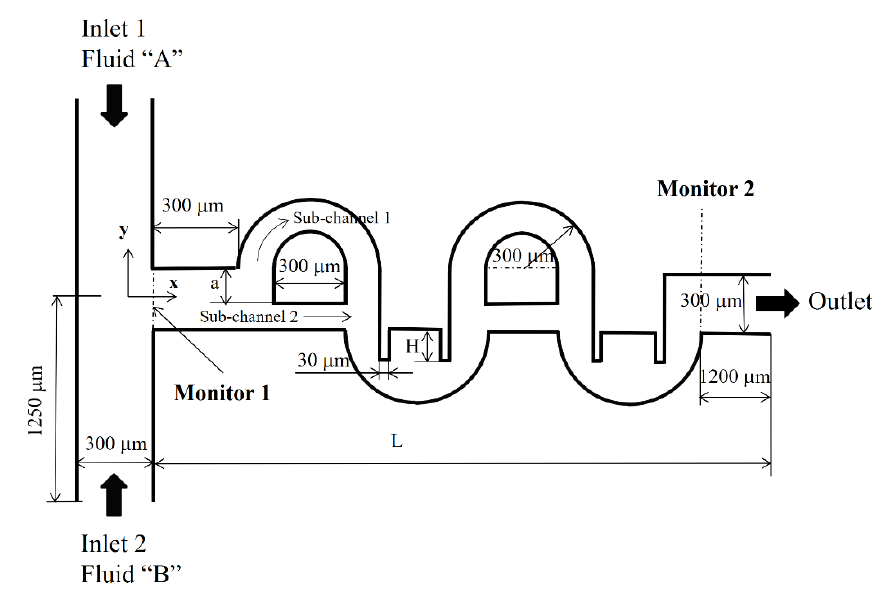
Figure 1. Diagram of a cross-channel split-and-recombine (CC-SAR) micro-mixer (non- proportional).